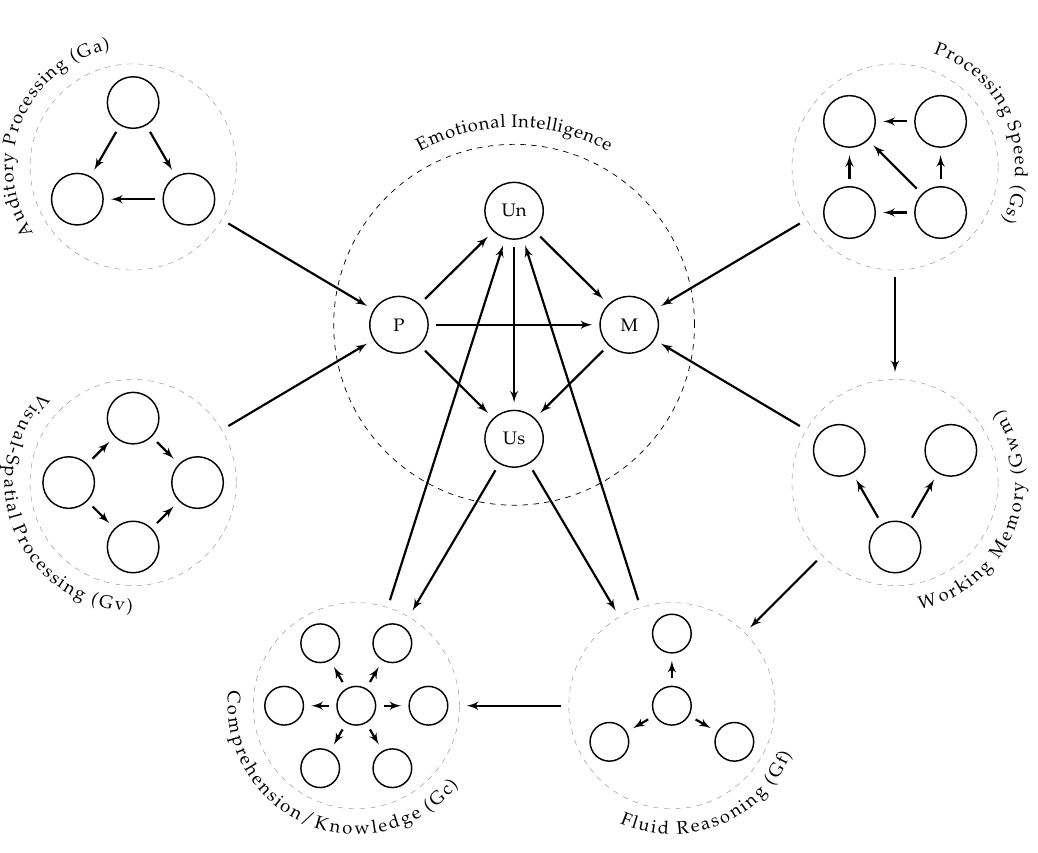
Figure 5. Emotional Intelligence and Cattell-Horn-Carroll Broad Abilities as Interdependent Causal Systems. P = Perceiving Emotions, Un = Understanding Emotions, M = Managing Emotions, Us = Using Emotions to Enhance